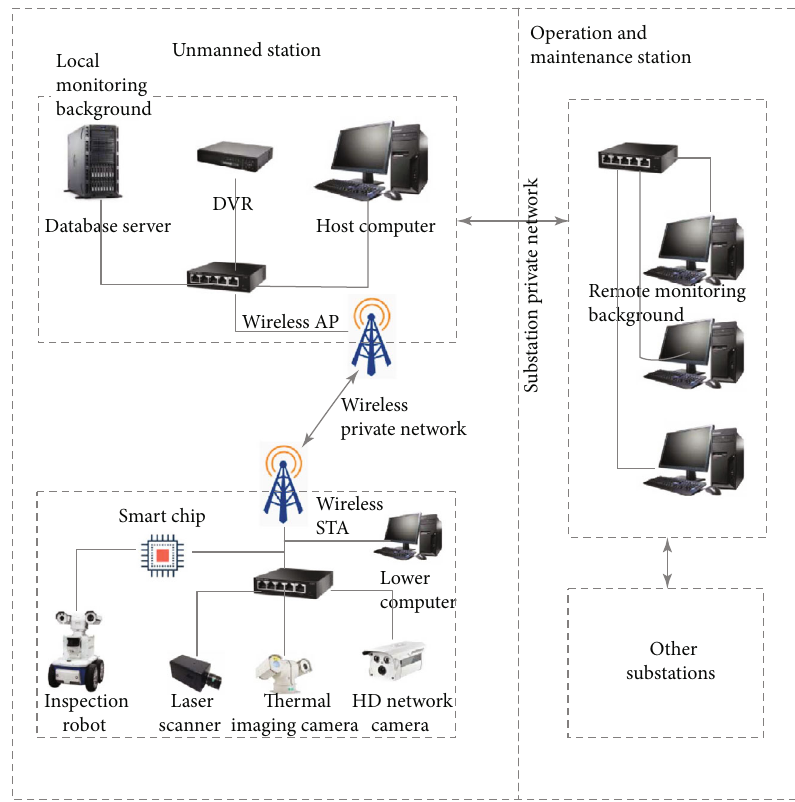
Figure 3: Topology diagram of intelligent inspection robot system for substation based on smart